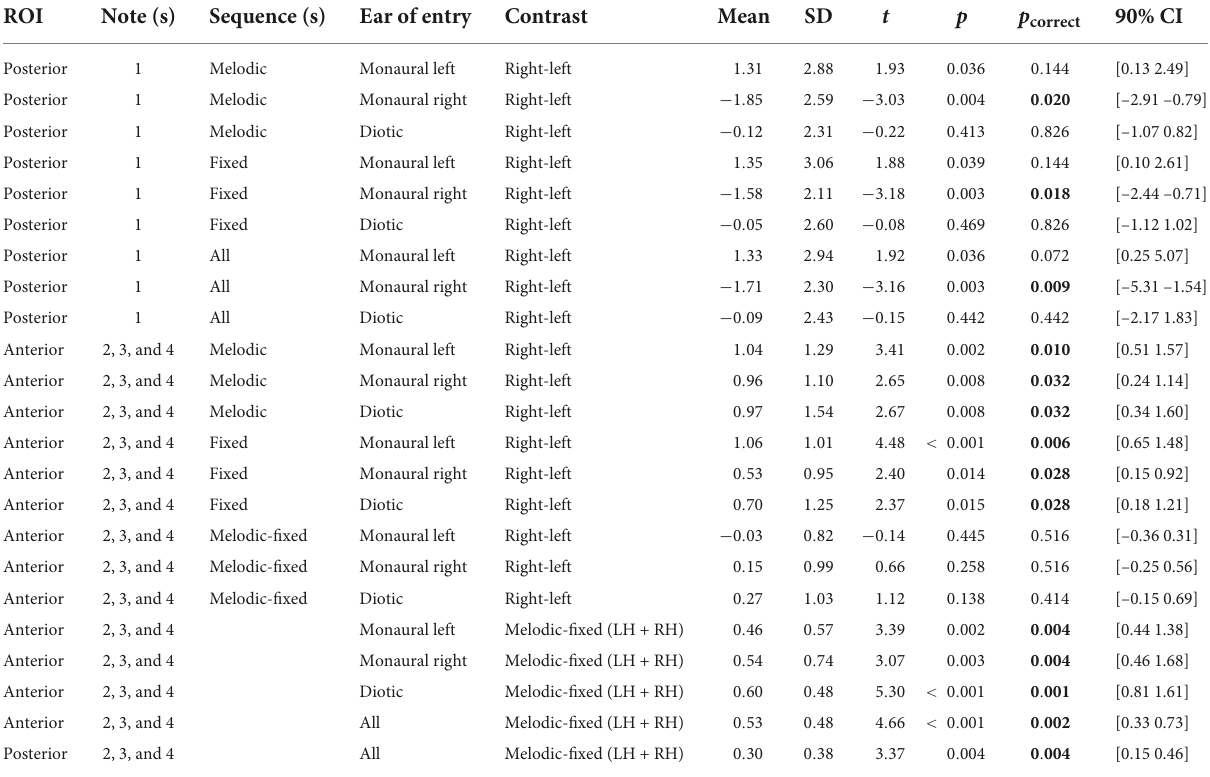
TABLE 1 Summary of post hoc tests for the reported